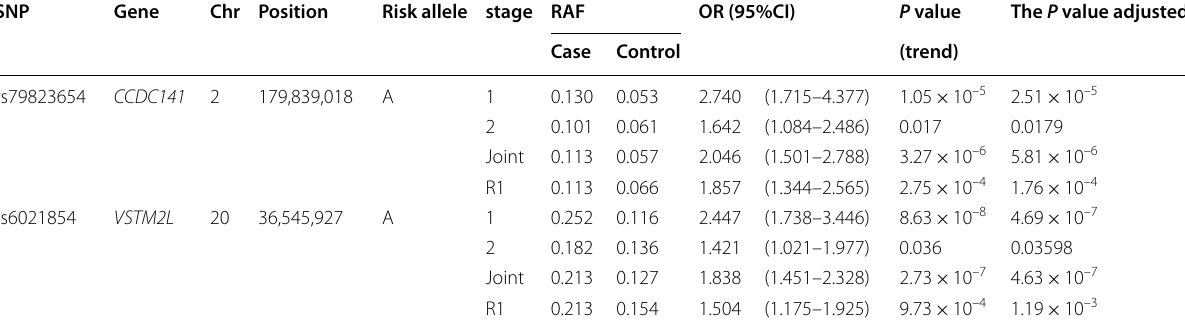
SNP single nucleotide polymorphism, Chr chromosome, OR odds ratio for risk allele, CI confidence interval, PC principal component; Stage 1 (GWAS) included 115 cases and 635 controls; Stage 2 (replication stage) included 149 cases and 748 controls; Joint: Combining stage 1 and 2; R1: combined cases (264 migraineurs with RLS) vs. 1,053 normal controls P value is derived from trend test, the P value adjusted is derived from the logistic regression adjusted with age and sex; Risk allele, allele with higher frequency in cases compared to controls. All genomic information is from human genome build